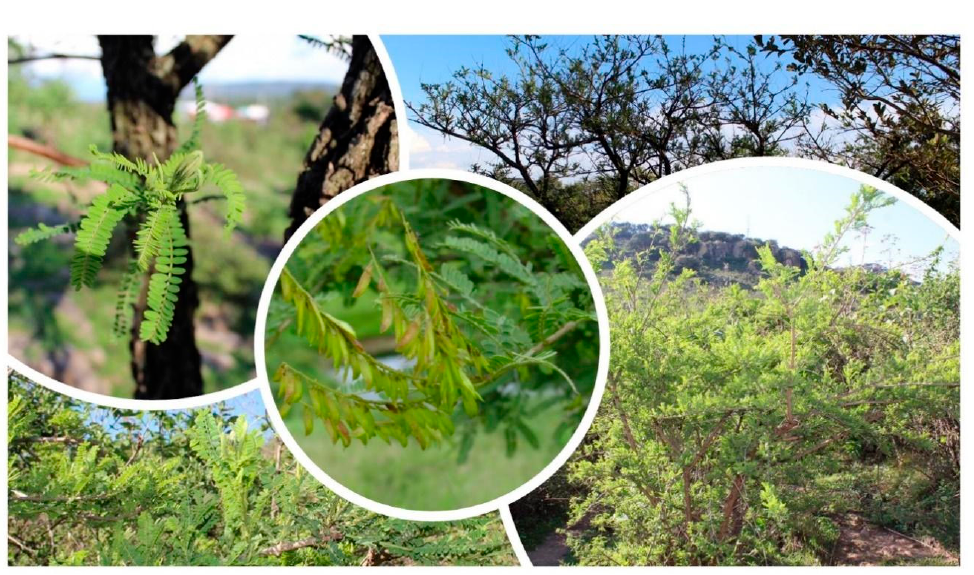
Figure 1. Eysenhardtia genus.